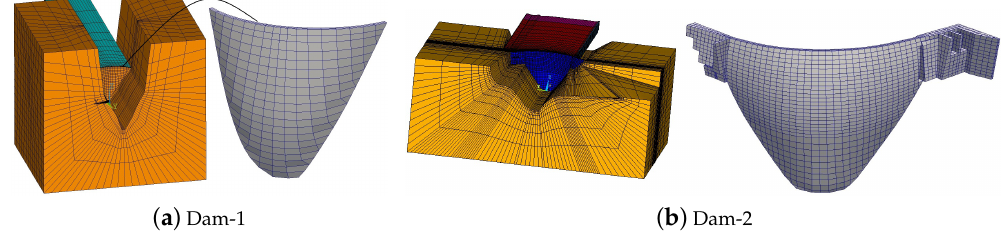
Figure 2. ( a , b ) Finite element mesh of two case study dams.